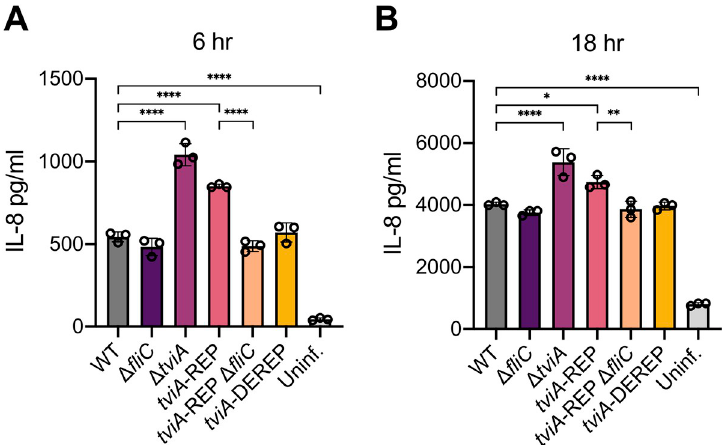
intestinal epithelial cell line HT-29 following infection for 6 (A) or 18 (B) hours with non-invasive WT, Δ fliC , Δ tviA , tviA -REP, tviA -REP Δ fliC , or tviA -DEREP S. Typhi at MOI = 25 or left uninfected. Data shown are representative of 2 (B) or 3 (A) independent experiments with triplicate samples for each condition. Data are represented as mean ± SD. Significance calculated using one-way ANOVA with Tukey’s correction. �� p < 0.01, ��� p < 0.001, ���� p <